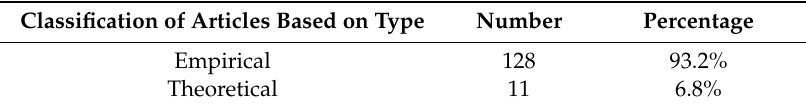
Table 1. Article classification based on